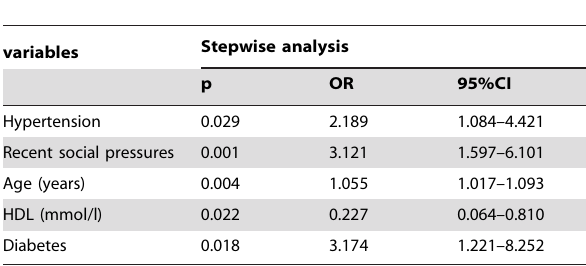
Table 3. Best model for association between telomere length (LTL) and lifestyle and laboratory parameters in a step wise multivariable model including all significant factors from univariable analyses in all subjects.